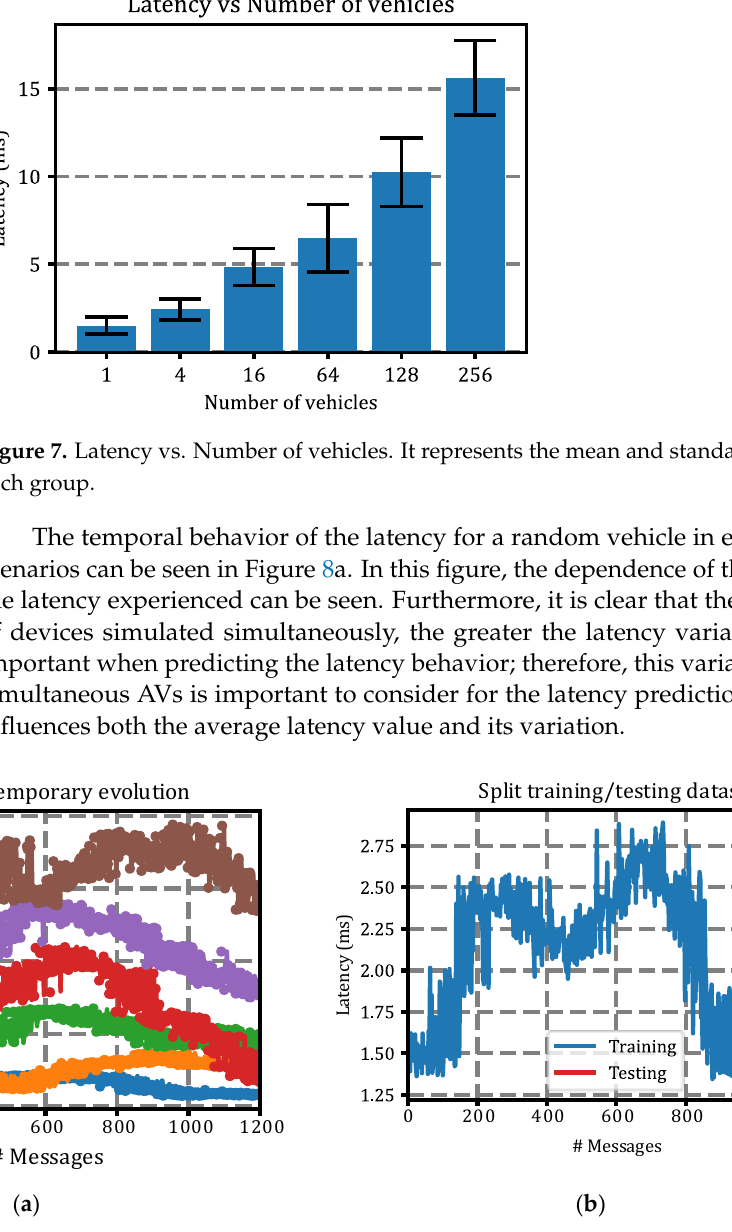
Figure 8. Latency behavior and split: ( a ) Latency temporary evolution for a random vehicle in each simulation group. The legend indicates the number of vehicles simulated simultaneously; ( b ) Example of dataset division. Up to latency sample (message), 1000 was used to form the training dataset, blue line. From the latency sample (message), 1000 was used for the test dataset, red line.